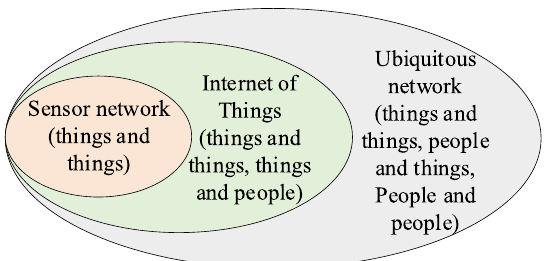
Fig. 3 The relationship among the ubiquitous network, IoT, and the sensor